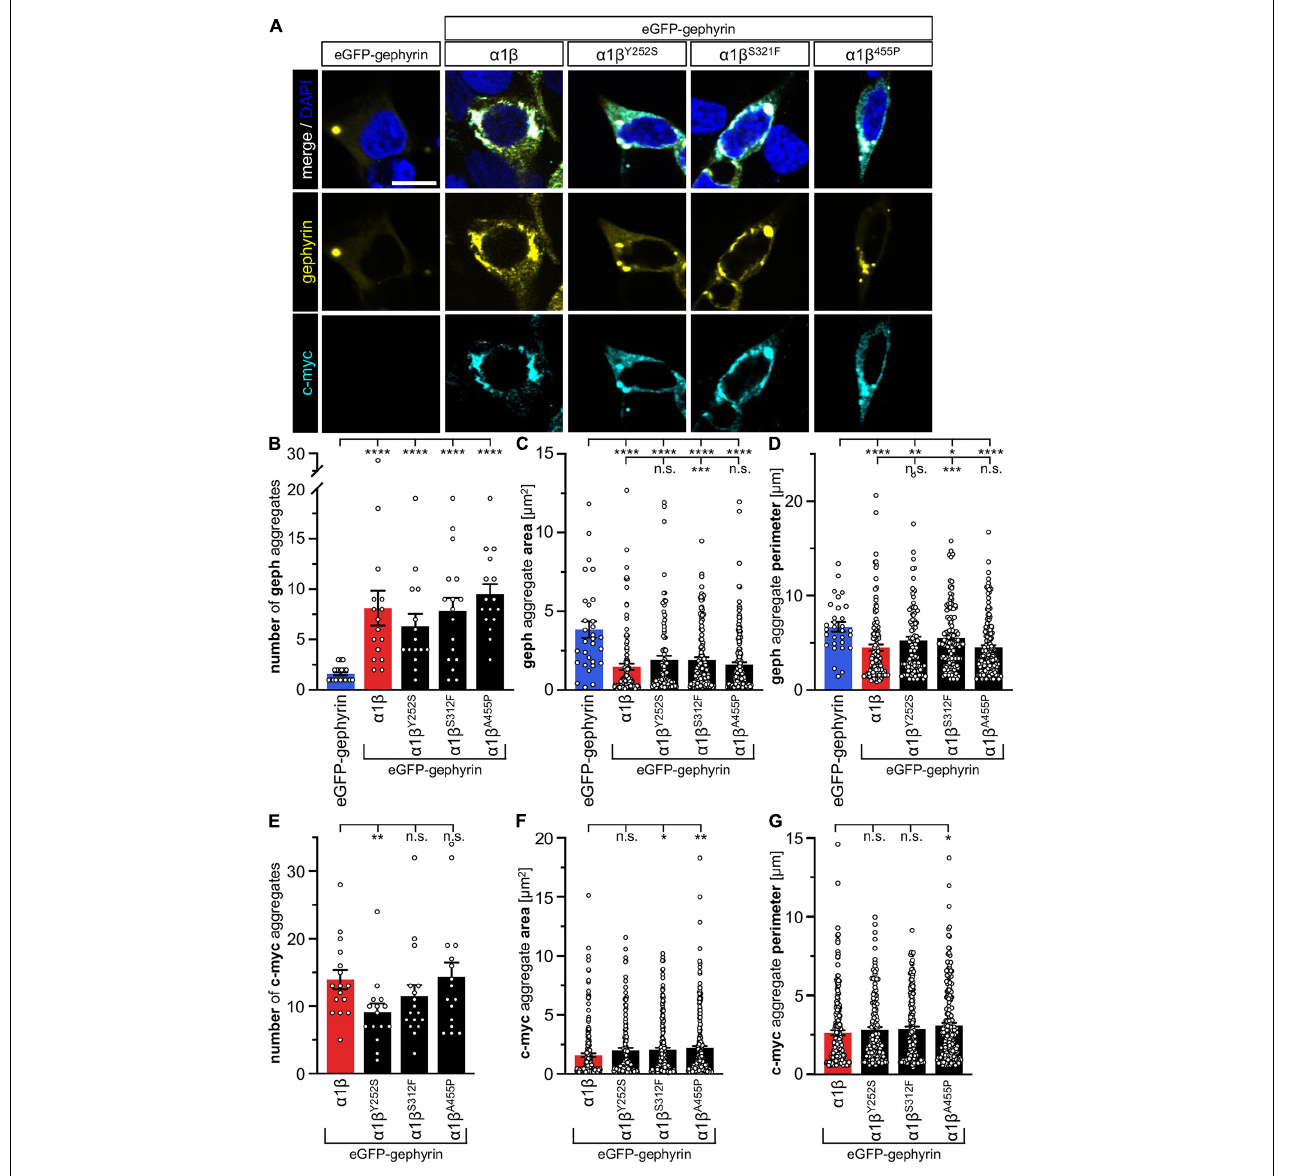
FIGURE 4 | GlyR β variants for cytoplasmic aggregates in the presence of gephyrin. (A) Immunocytochemical stainings of HEK-293 cells transfected with eGFP-gephyrin alone or GlyR α 1, eGFP-gephyrin and β WT or β variants (Y252S, S321F and A455P; ratio 1:5:10). Myc-tagged GlyR β WT or missense variants were stained with a specific anti-myc antibody (cyan, lower lane), eGFP-gephyrin is shown in yellow (middle lane), merge images are depicted in the upper lane. Nucleus is marked in blue (DAPI). Scale bar refers to 10 µ m in all images. (B–G) Bar graphs of gephyrin aggregate analysis of HEK-293 cells expressing eGFP-gephyrin (blue bars), eGFP-gephyrin and α 1 β WT (red bars) or eGFP-gephyrin and α 1 β variants (black bars): (B) number of gephyrin aggregates, (C) area of gephyrin aggregates, (D) perimeter of gephyrin aggregates, (E) number of β (c-myc) aggregates, (F) area of β (c-myc) aggregates, (G) perimeter of β (c-myc) aggregates, * p < 0.05, ** p < 0.01, *** p < 0.001, **** p <